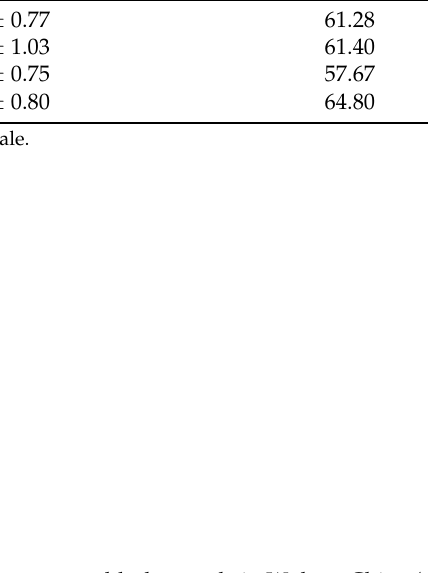
Figure 1. Reading habit of COVID-19 information among elderly people in Wuhan, China ( n = 907). Table 2. Reasons for COVID-19 information avoidance among elderly people in Wuhan, China ( n = 907).